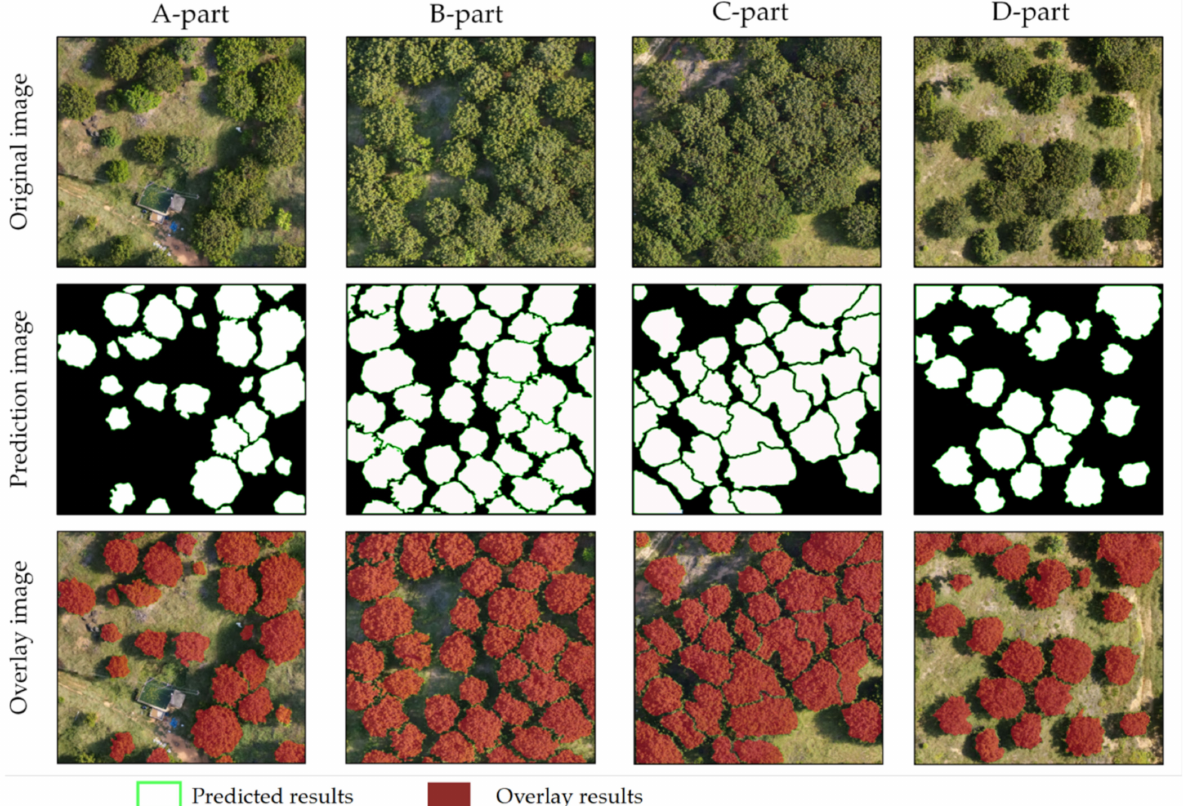
Figure 10. Segmentation results using the U 2 -Net